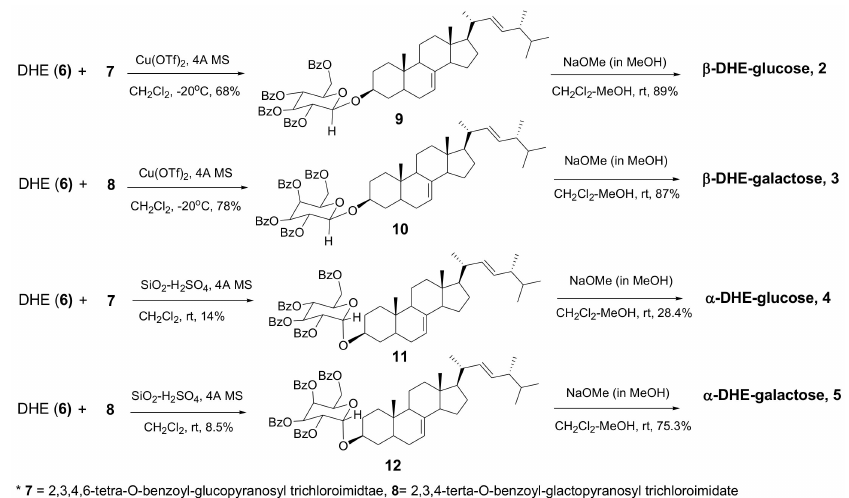
Scheme 2. Synthesis of α - and β -anomers of DHE-Glc and